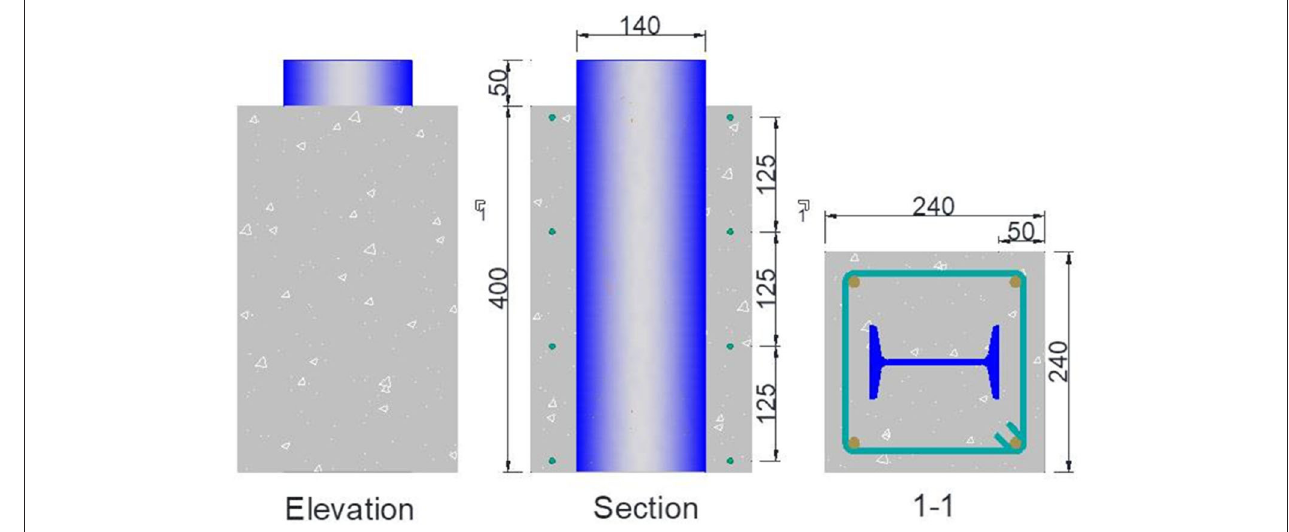
FIGURE 1 | Dimensions and structure of